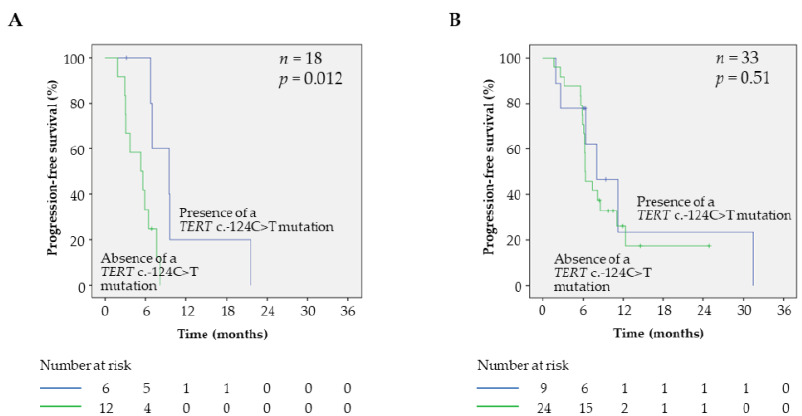
Figure 4. Effect of TERT c.-124C>T mutation on clinical outcome of BRAF V600 patients with or without brain metastasis. ( A ) Kaplan–Meier analyses of PFS in patients with brain metastasis in function of the TERT c.-124C>T mutation status. ( B ) Kaplan–Meier analyses of PFS in patients without brain metastasis in function of the TERT c.-124C>T mutation status.